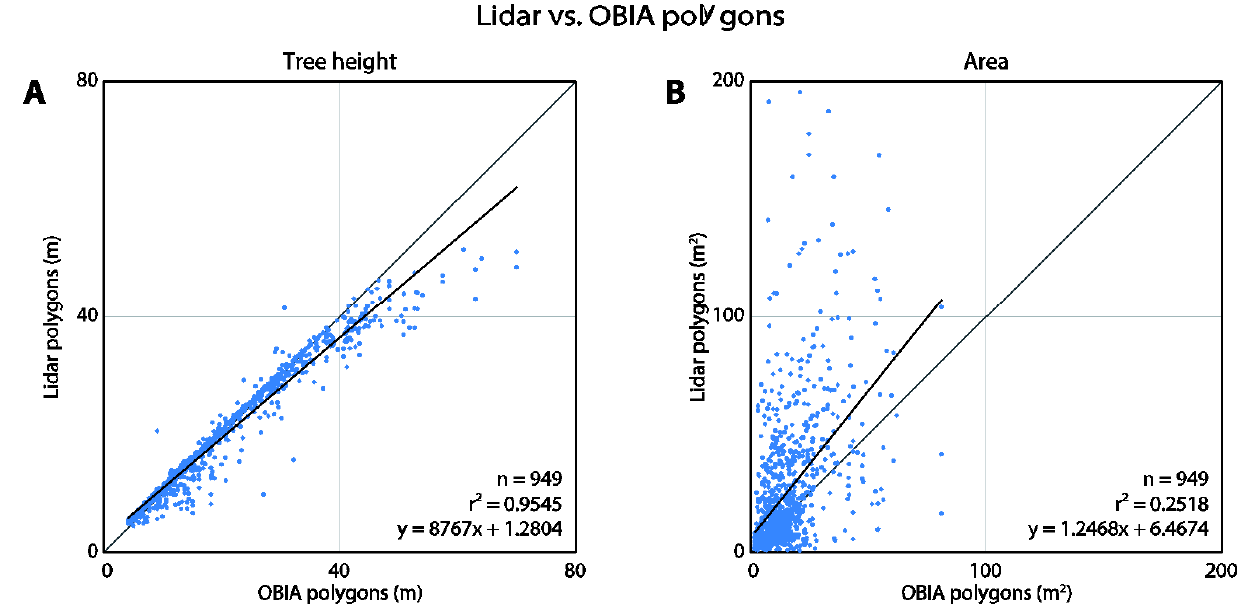
Figure 9. ( A ) The tree-heights derived by the two methods were more similar than ( B ) their shape in terms of the area or ( C , D )shape